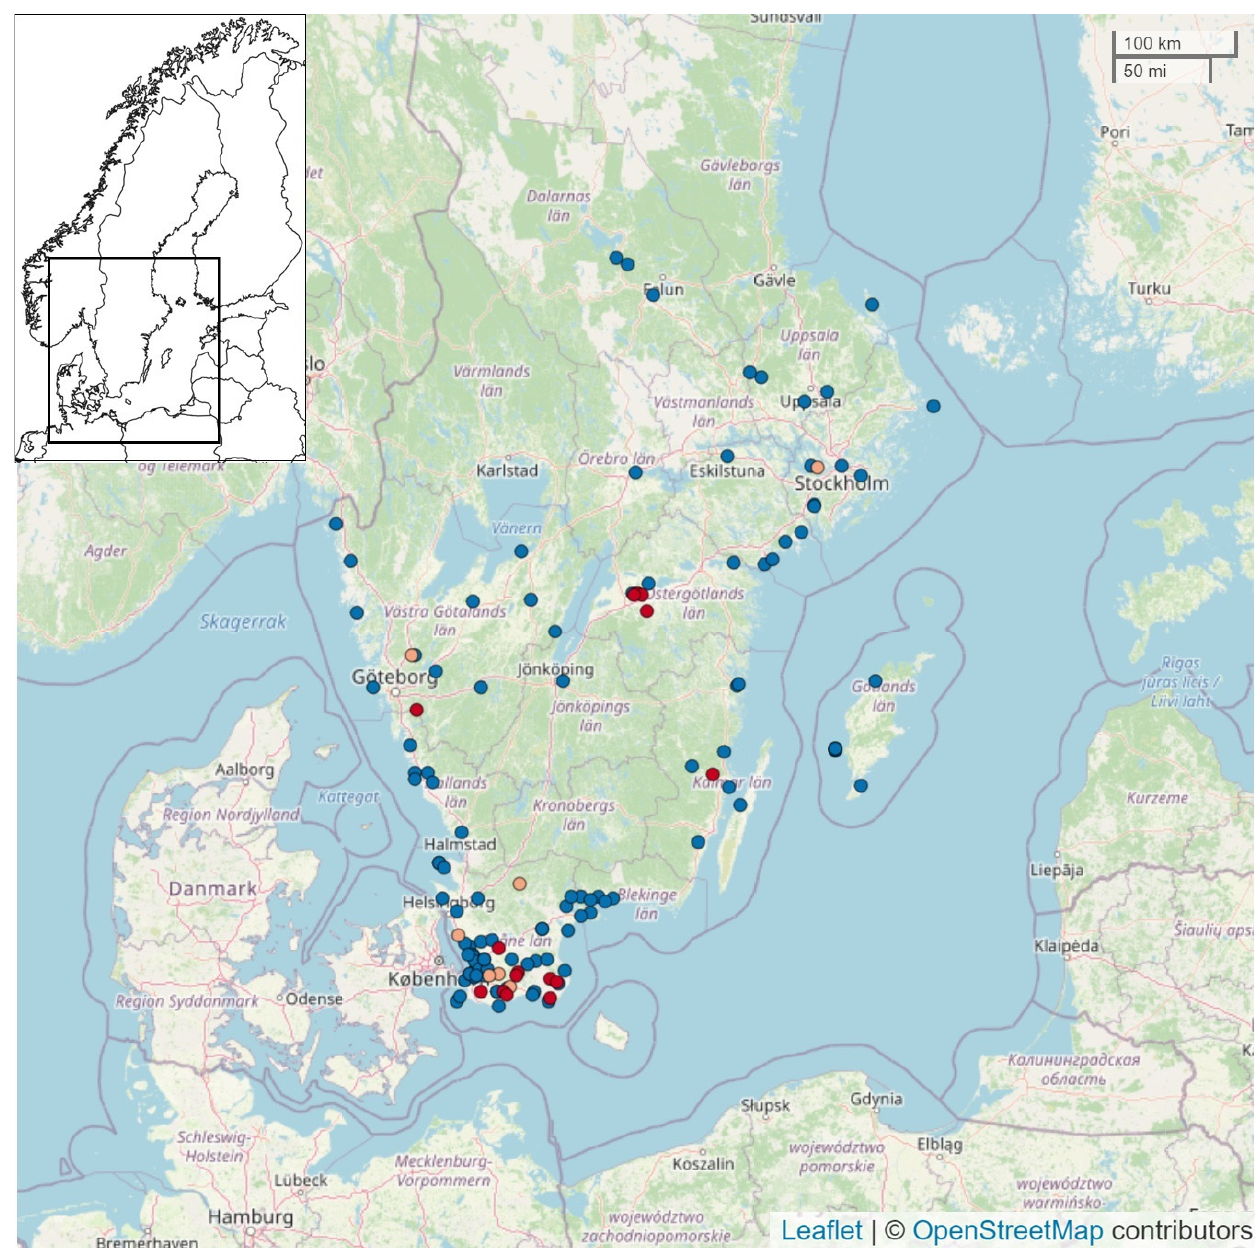
Figure 2. Geographic locations of reported cases of HPAI in poultry (red), other captive birds (yellow) and wild birds (blue) during the influenza season 2020–2021 in Sweden. Wild bird locations represent single or multiple infected birds. Maps generated with data from OpenStreetMap ® , https://www.openstreetmap.org/copyright, accessed on 27 May 2022, Source: European Animal Disease Information System [28]. Access date 25 May